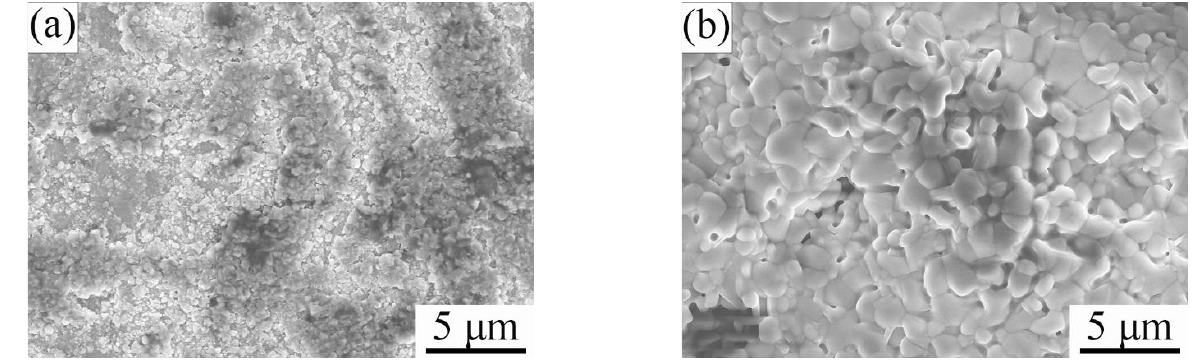
Figure 3. Scanning electron microscope (SEM) micrographs of sample surface of Ti 2 AlC ceramic quenched in air at different temperatures: ( a ) 920 °C and ( b ) 1150 °C.